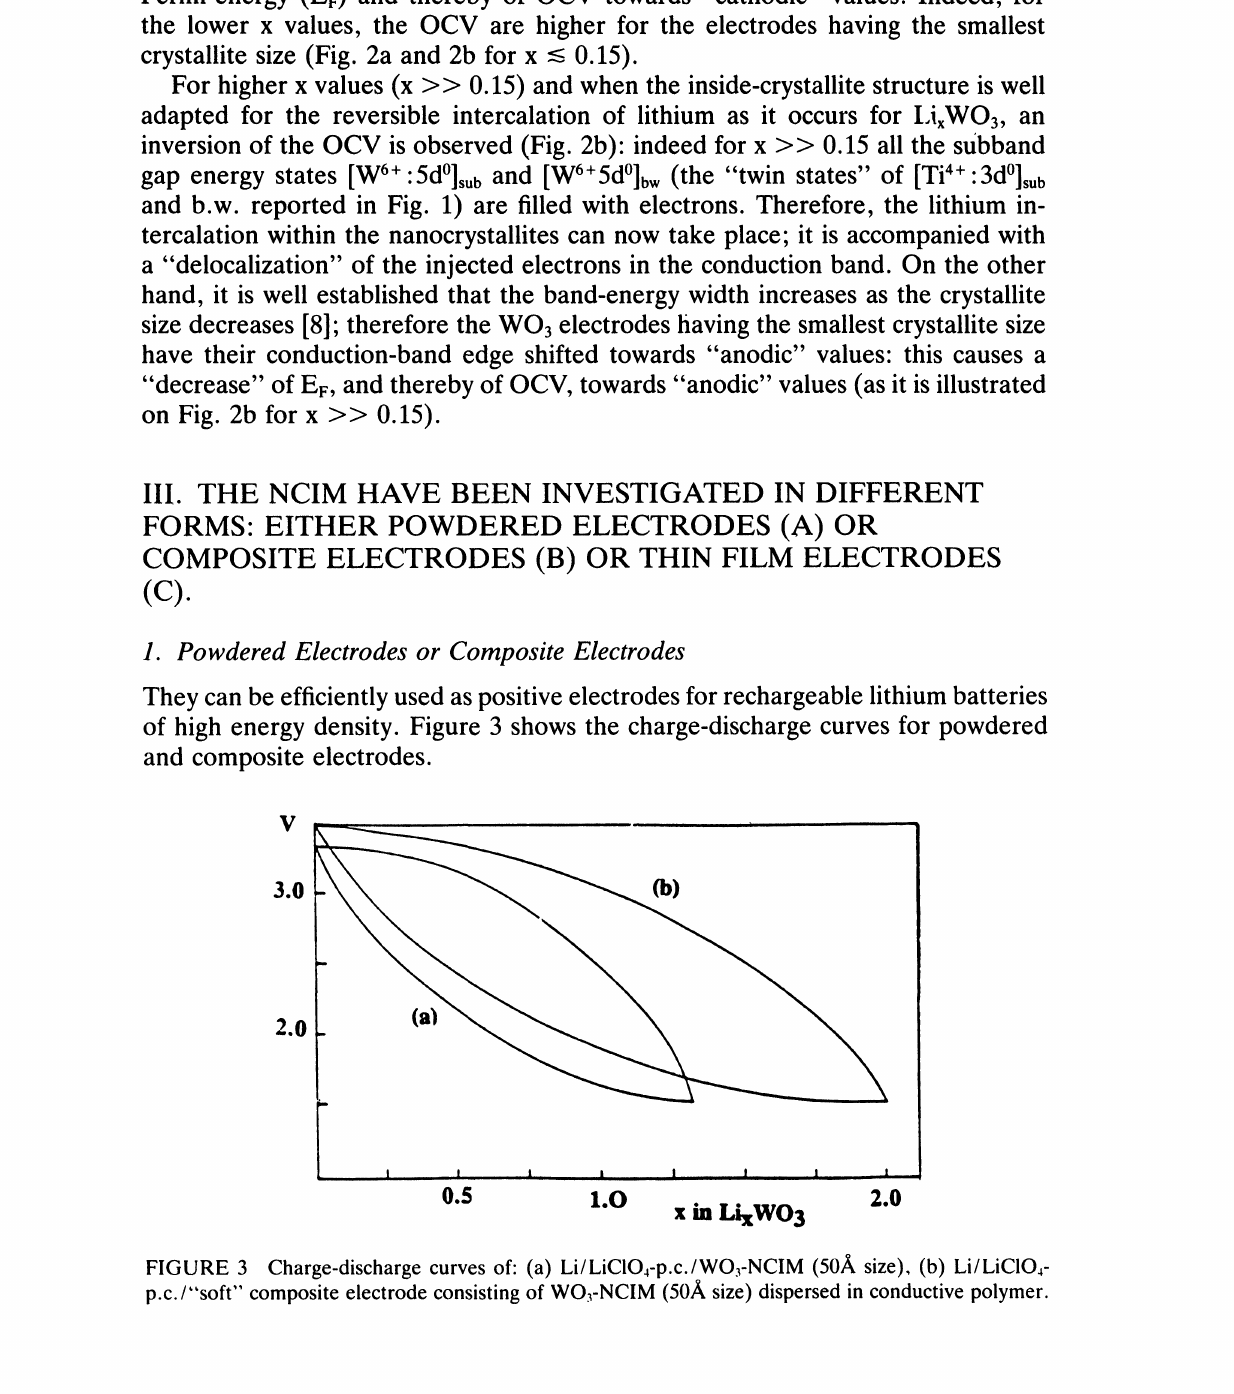
FIGURE 3 Charge-discharge curves of: (a) Li/LiCIO4-p.c./WO3-NCIM (50/ size), (b) Li/LiCIO4- p.c./"soft" composite electrode consisting of WOs-NCIM (507k size) dispersed in conductive